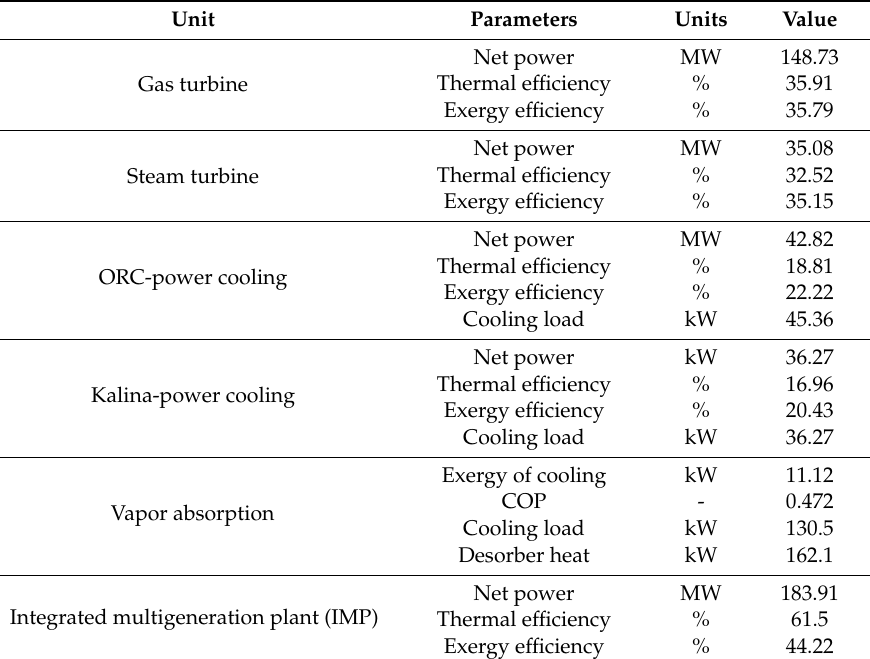
Table 3. Thermodynamic performance of the IMP.